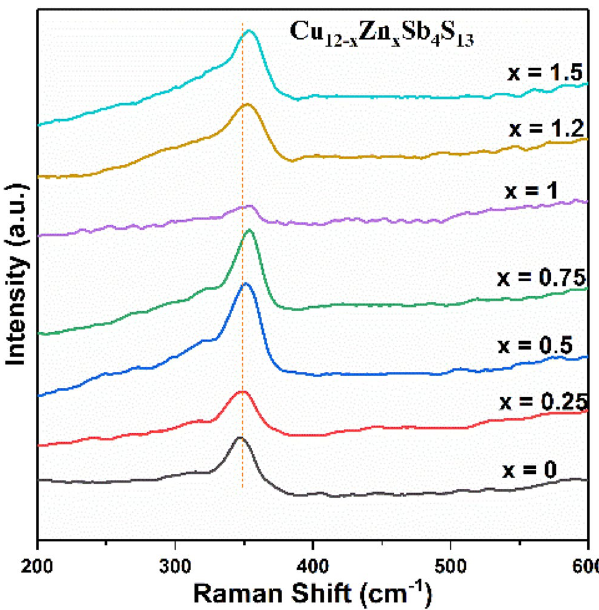
Figure 10. Raman spectra of Zn-doped tetrahedrite Cu 12−x Zn x Sb 4 S 13 (x = 0.25, 0.5, 0.75, 1, 1.2, 1.5).